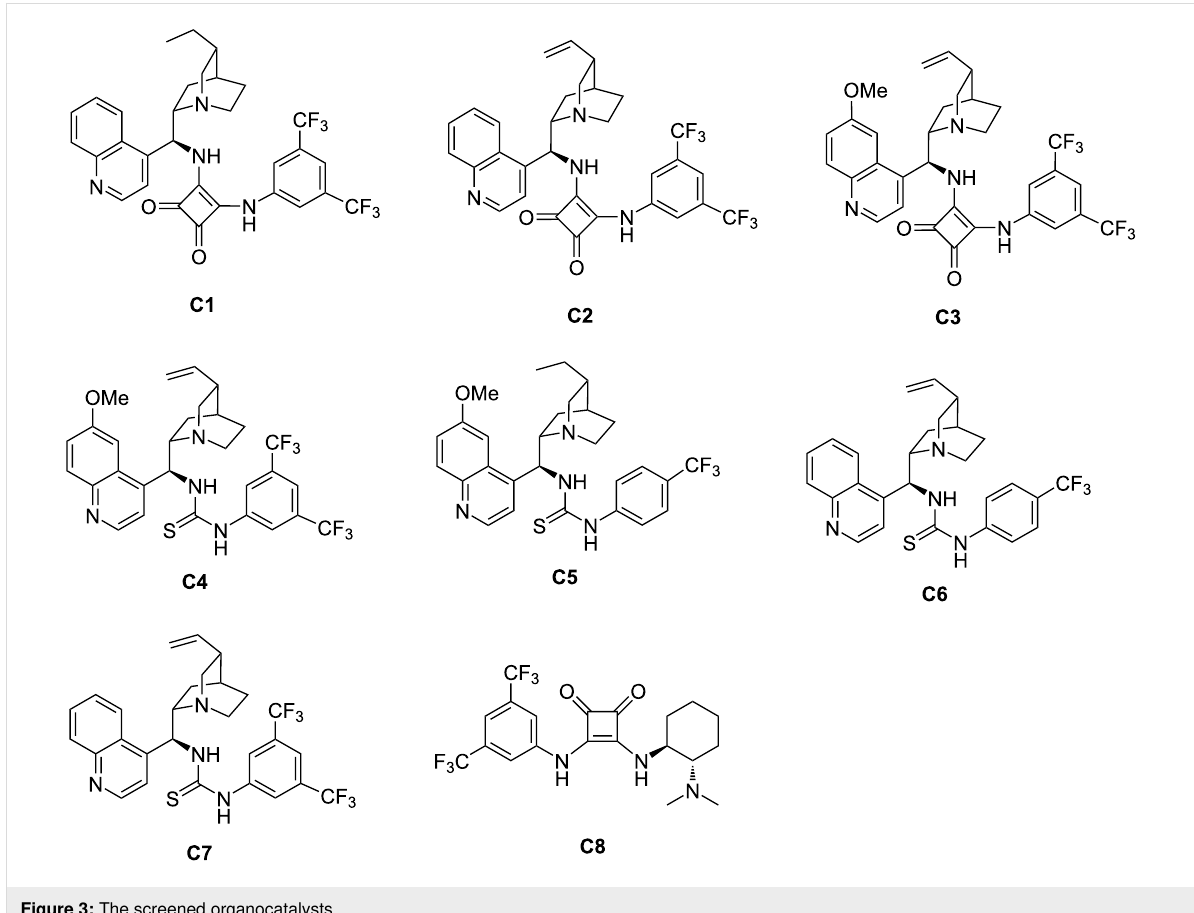
Figure 3: The screened